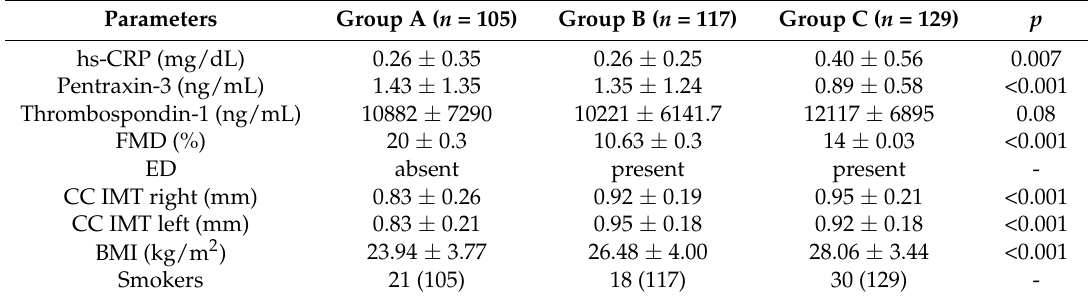
Table 3. The principal indicators of the presence/absence of ED.